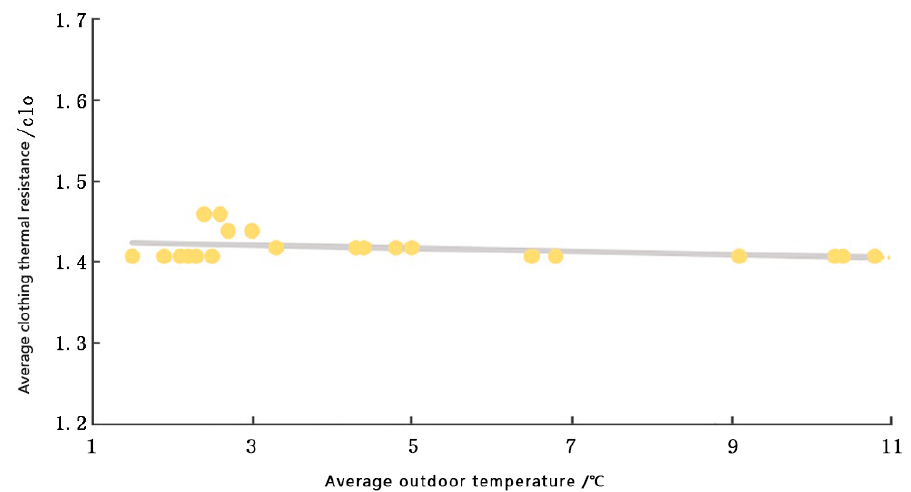
Figure 13. Outdoor temperature–garment thermal resistance graph (source: